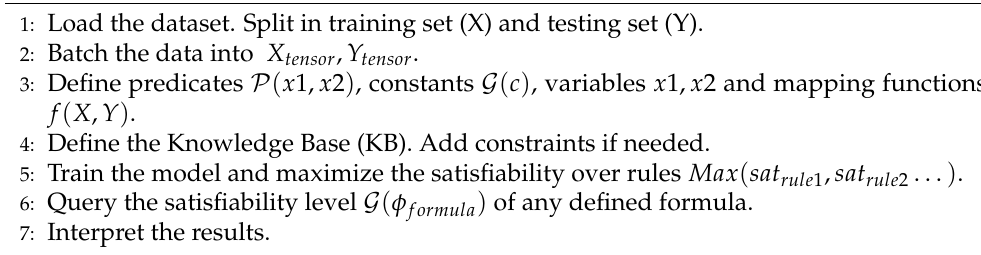
Algorithm 1 The generic hybrid